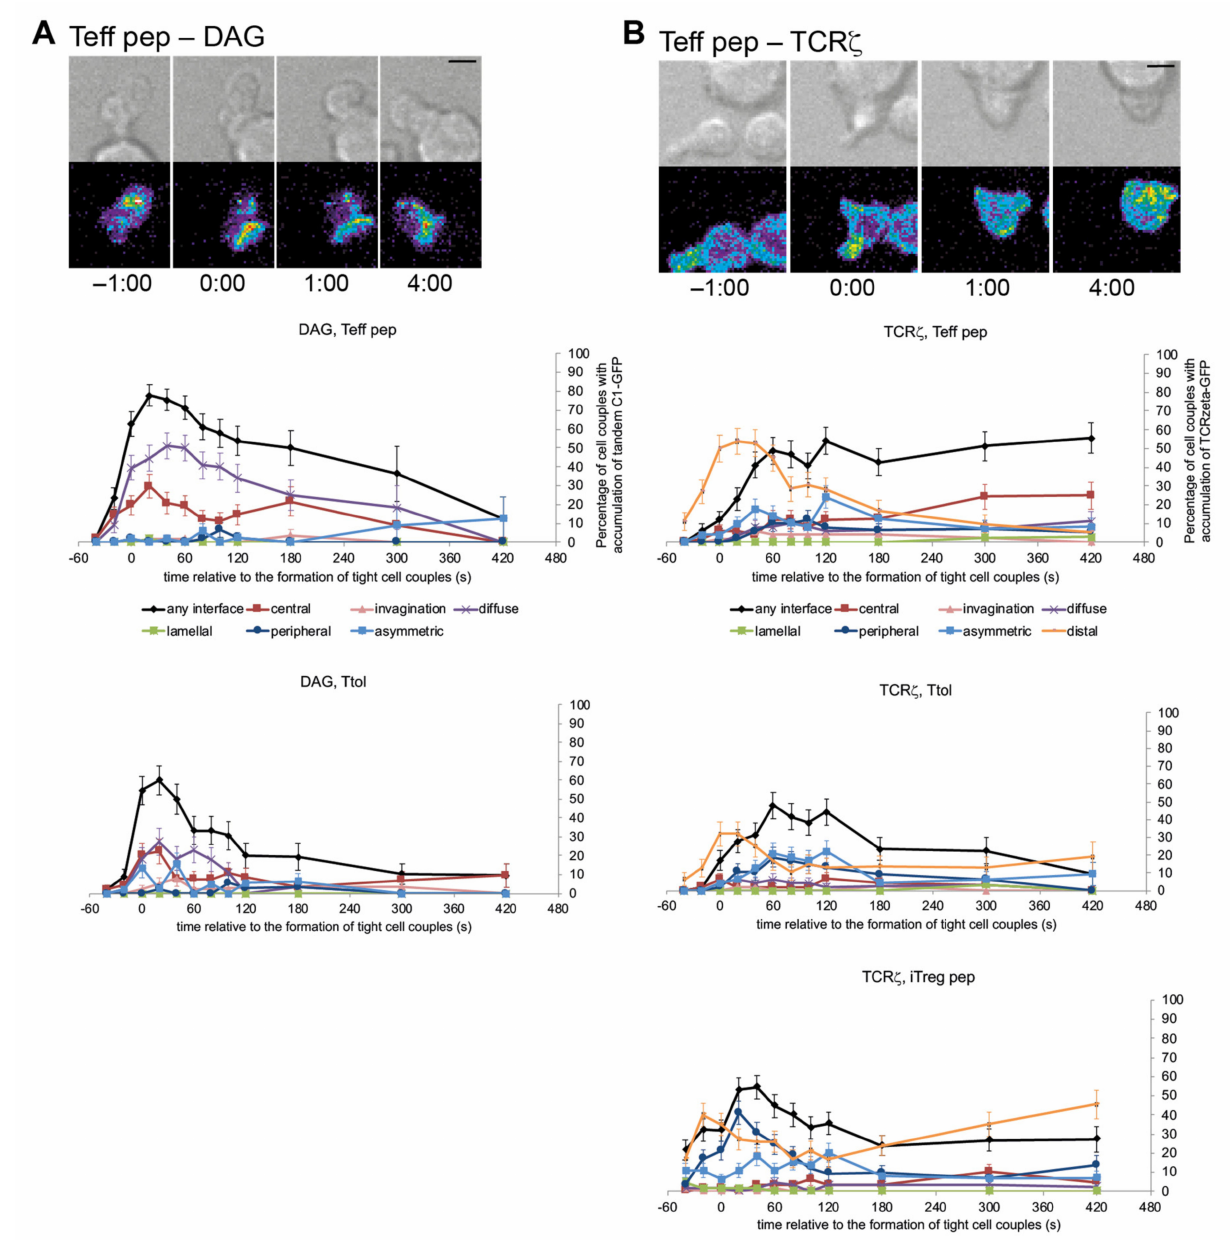
Figure 3. cSMAC formation was diminished but not abolished upon induction of a regulatory phenotype. ( A ) Tg4 T cells as indicated transduced to express Tandem C1-GFP as indicated were activated with PL8 APCs (10 µ g/mL Ac1-9[4Y]). On the left, representative tandem C1-GFP imaging data as in Figure 2A. A corresponding video is available as Video S5. On the right, data are expressed as the percentage of cell couples with DAG accumulation measured with tandem C1-GFP in the indicated patterns (Supplementary Figure S2A) relative to tight cell couple formation. Number of cell couples analyzed are n = 56, 45 for Teff pep and Ttol cells, respectively, from 1 independent experiment each. Statistical significance of differences between conditions is given in Table S3. ( B ) Tg4 T cells as indicated transduced to express TCR ζ -GFP were activated with PL8 APCs (10 µ g/mL Ac1-9[4Y]). On the top left, representative TCR ζ -GFP imaging data as in Figure 2A. A corresponding video is available as Video S6. Data are expressed as the percentage of cell couples with TCR ζ -GFP accumulation in the indicated patterns (Supplementary Figure S2A) relative to tight cell couple formation. Number of cell couples analyzed are n = 52, 48, 66 for Teff pep, Ttol, iTreg pep cells, respectively, from 3–5 independent experiments. Statistical significance of differences between conditions is given in Table